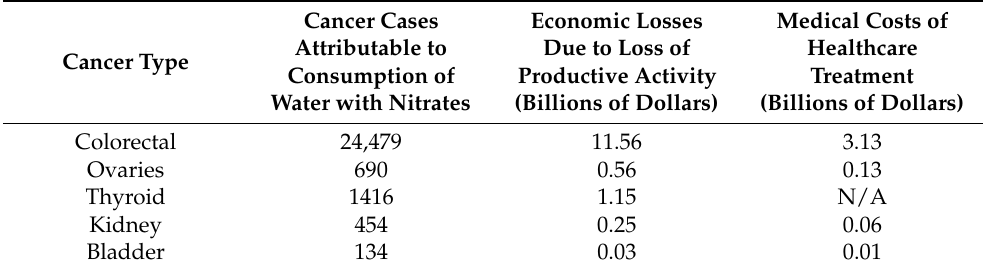
Table 5. Cancer cases, costs from the loss of productive activities, and medical costs related to water-polluted consumption with nitrates in 2014